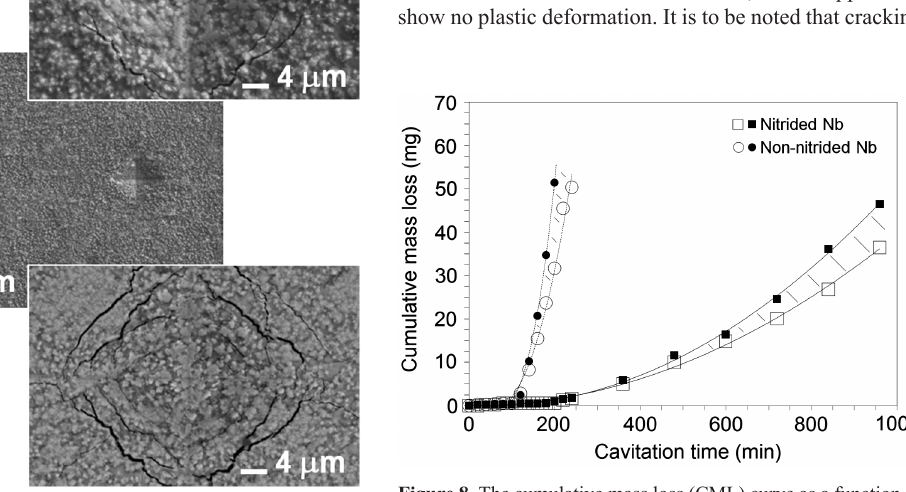
Figure 7. SEM image of microhardness (Vickers) indentations performed at 2 N load in the nitrided niobium surface (in central). Indentation detail attained by using secondary (at the top), and backscattered electron (at the bottom) detectors.